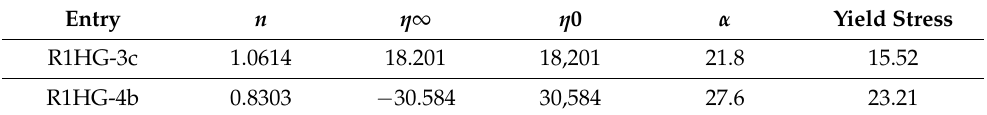
Table 7. Parameters of the Cross rheology equation and yield stress value of R1HG-3c and R1HG-4b. Entry n η ∞ η 0 α Yield Stress R1HG-3c